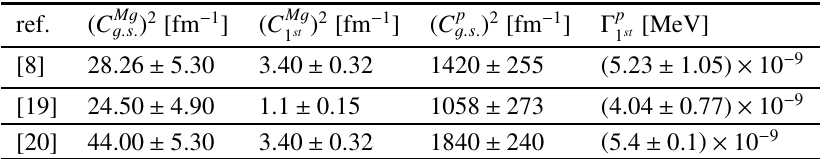
Table 1. Values found in [8] and compared with [19] and [20]. The ANC values for the capture in the ground (first column) and the 1 st excited state (second column) for the neutron capture 26 Mg( n , γ ) 27 Mg from the three publications are reported, along with the proton ANC (third column) for the capture in the ground state and the proton width Γ p for the 26 Si( p ,γ ) 27 P (fourth column).